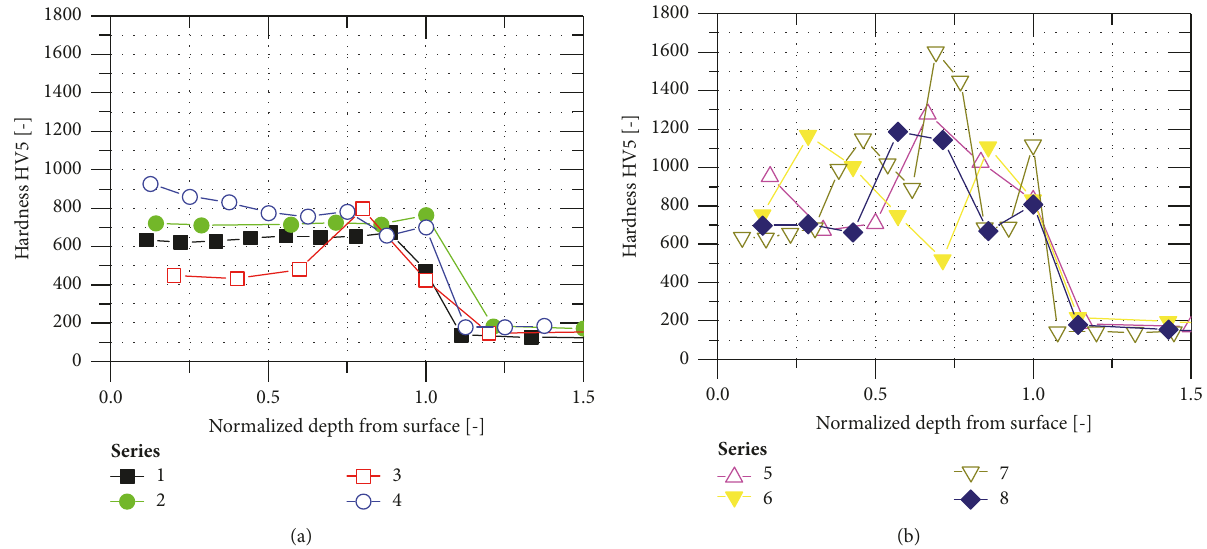
Figure 4: Vickers HV5 hardness over normalized thickness of the hardfacing layer from test series 1–5 (a) and series 6–10 (b).